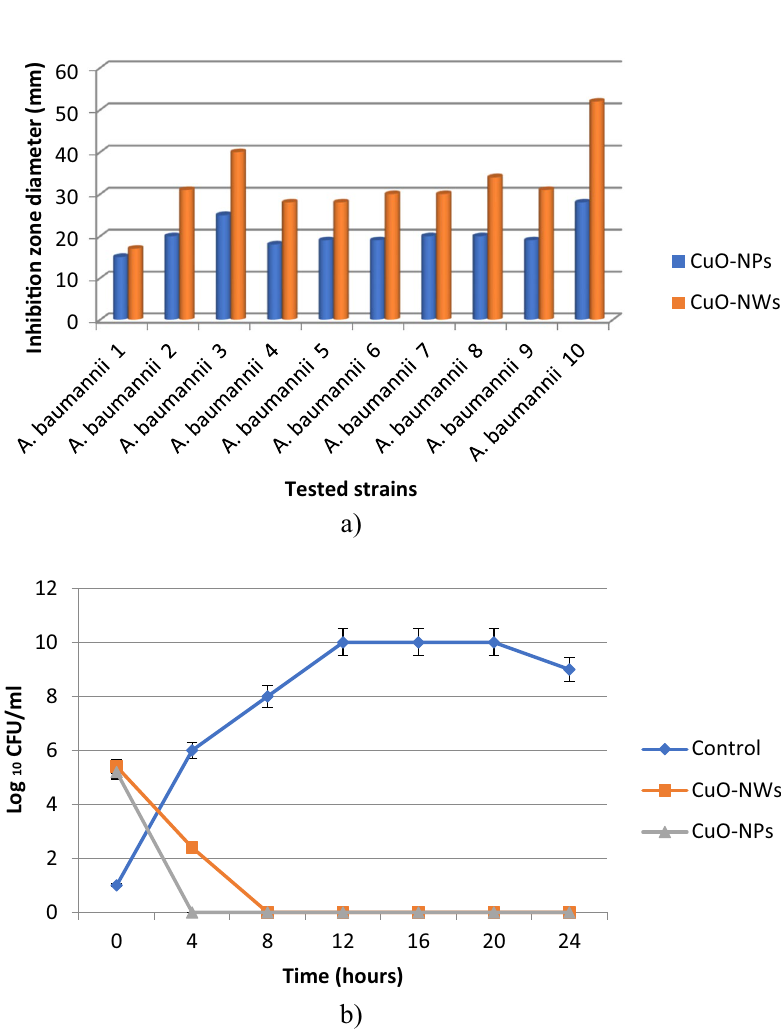
Figure 6. Antibacterial effect of CuO-NWs & CuO-NPs against Acinetobacter baumannii strains represented in inhibition zone diameter ( a ), and the bacterial lethality curve ( b